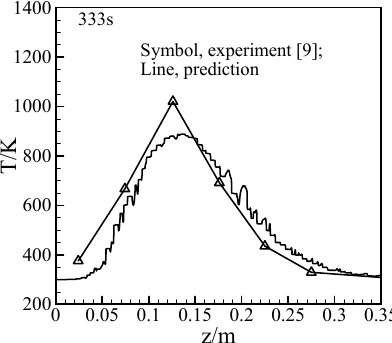
Figure 3. The Prediction of thermal wave for u g = 0.43 m/s and t = 333 s.